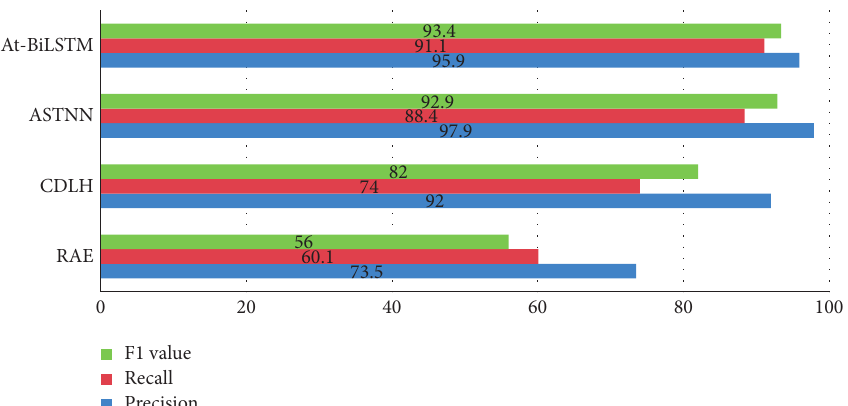
Figure 7: Code clone detection models on BigCloneBench.